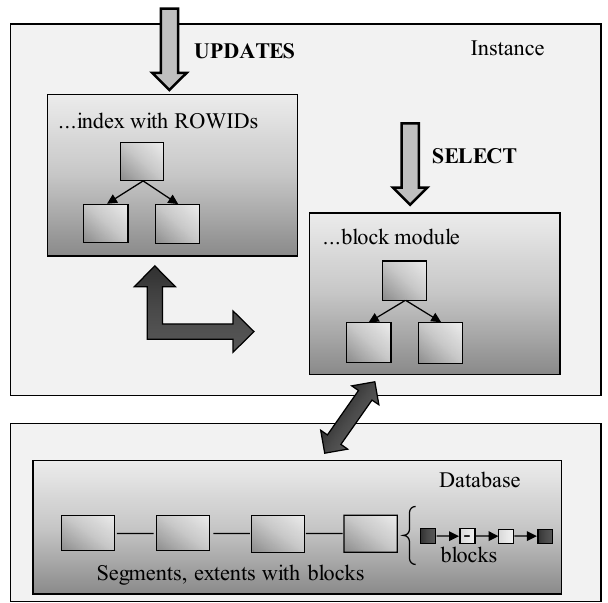
Figure 8. The architecture of the solution – block management.